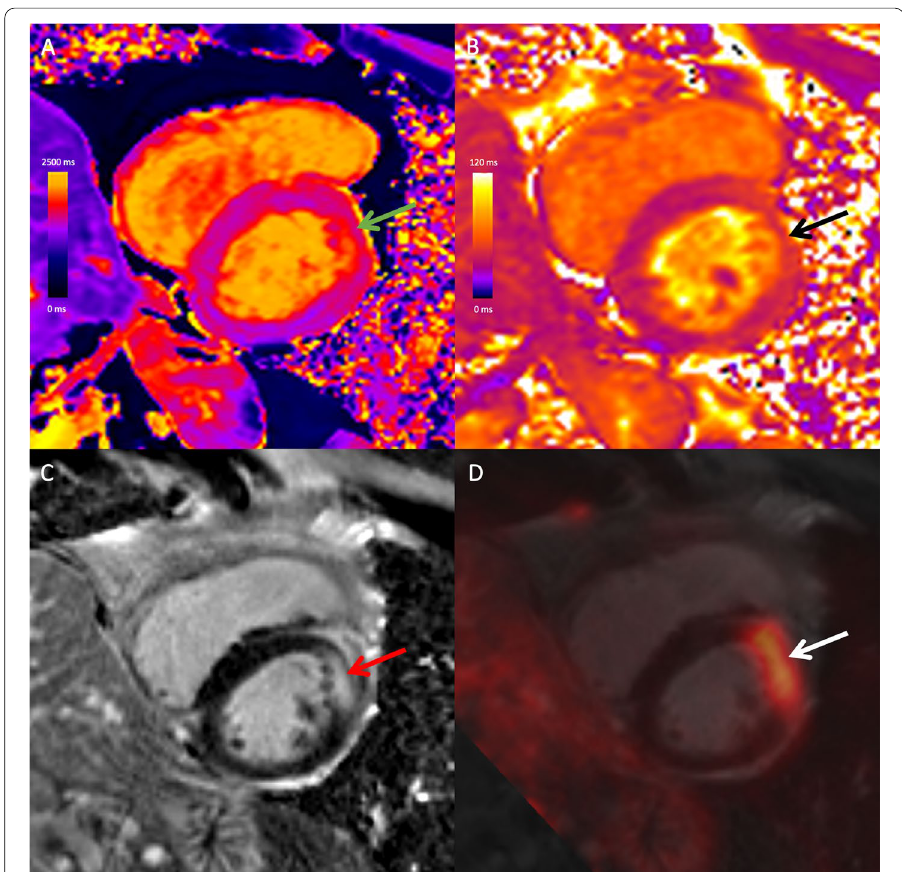
Fig. 1 Combined 18F‑FDG PET/MRI images in a 67‑year‑old male with cardiac and extra‑cardiac sarcoidosis. Mid‑ventricular short‑axis native T1 map ( A ), native T2 map ( B ), late gadolinium‑enhanced (LGE) image ( C ), and fused 18F‑FDG PET and LGE image ( D ) demonstrate high T1 (green arrow), high T2 (black arrow), mid‑wall LGE (red arrow) and co‑localizing focal FDG uptake (white arrow) at the mid‑anterior wall. There was extra‑cardiac FDG uptake in mediastinal and hilar lymph nodes (not shown). The study was positive on both PET and MRI, likely reflecting active cardiac sarcoidosis with myocardial